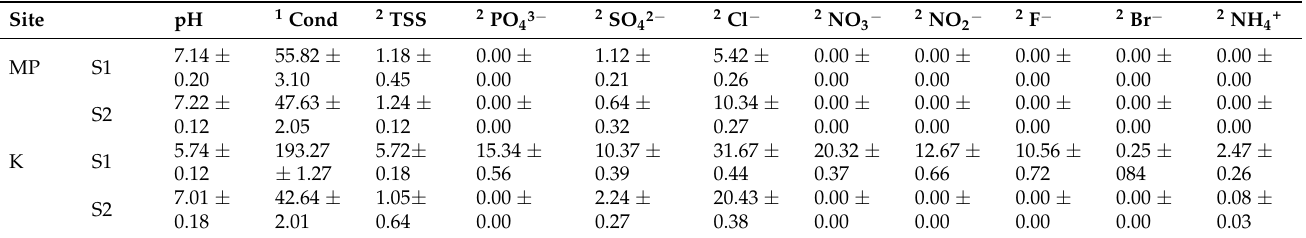
Table 1. Physicochemical analysis of the collected samples during different time periods (S1 and S2) from Mikri Prespa (MP) and Kastoria (K) lakes.